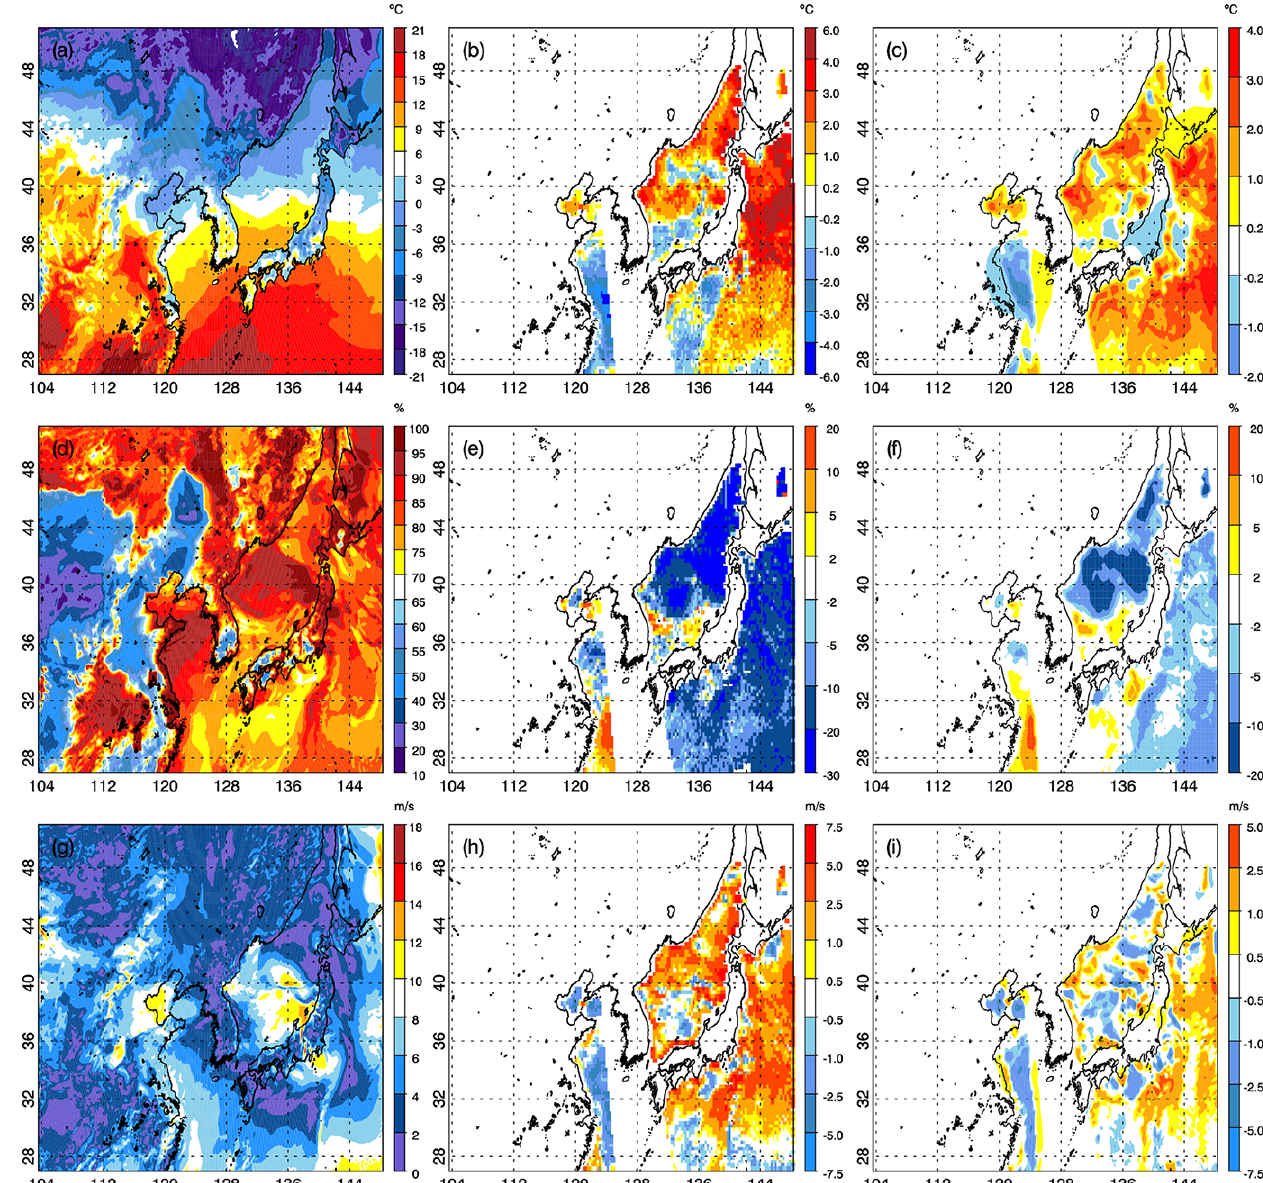
Figure 12. WRF model background fields for (a) 2m temperature ( ◦ C), (d) 2m relative humidity (%), and (g) 10m horizontal wind speed (ms − 1 ). The difference between GPM-retrieved observation and model background fields for (b) 2m temperature, (e) 2m relative humid- ity, and (h) 10m horizontal wind speed. The difference between the data assimilation analysis and model background field for (c) 2m temperature, (f) 2m relative humidity, and (i) 10m horizontal wind speed at 09:00UTC 27 February